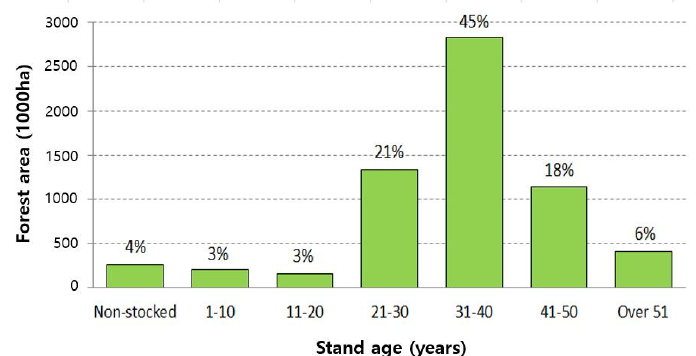
Figure 1. Age distribution of forest stands in South Korea [9]. The “Non-stocked” indicates the areas that include bamboo forests, eroded lands, roads, etc.